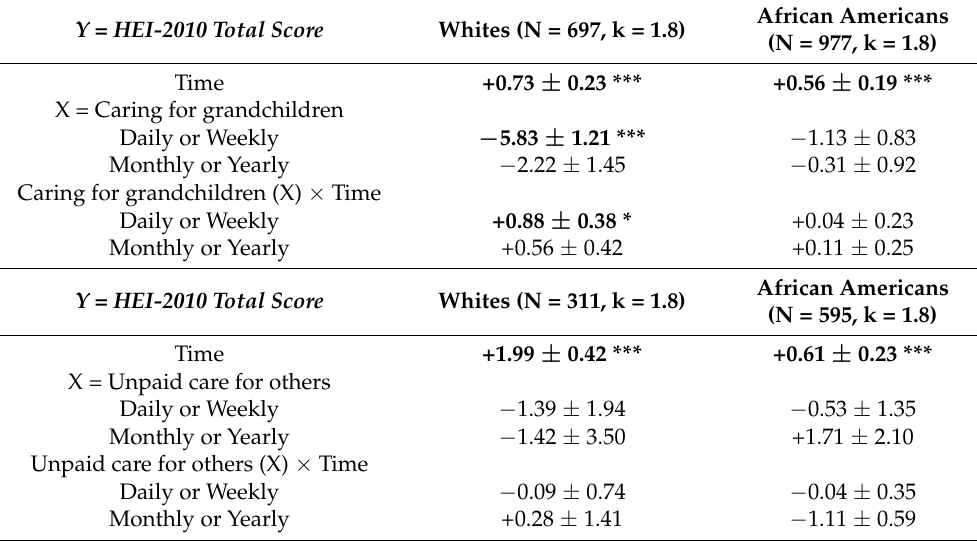
Table 4. Longitudinal Associations of caregiving exposures (X = recoded questions 3 and 6) with diet quality (Y = HEI-2010 total score) over time, stratified by race, for HANDLS participants (N = 1674) [ γ ± SE, p -value]: Mixed-effects linear regression models 1 .